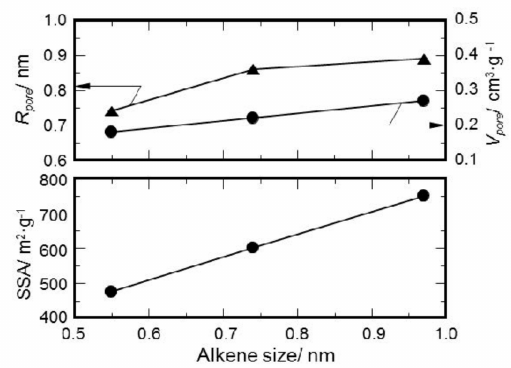
Figure 10. Textural properties of ROSZ-derived amorphous Si–O–N samples as a function of an estimated molecular size of alkene formed in-situ during pyrolysis in N 2